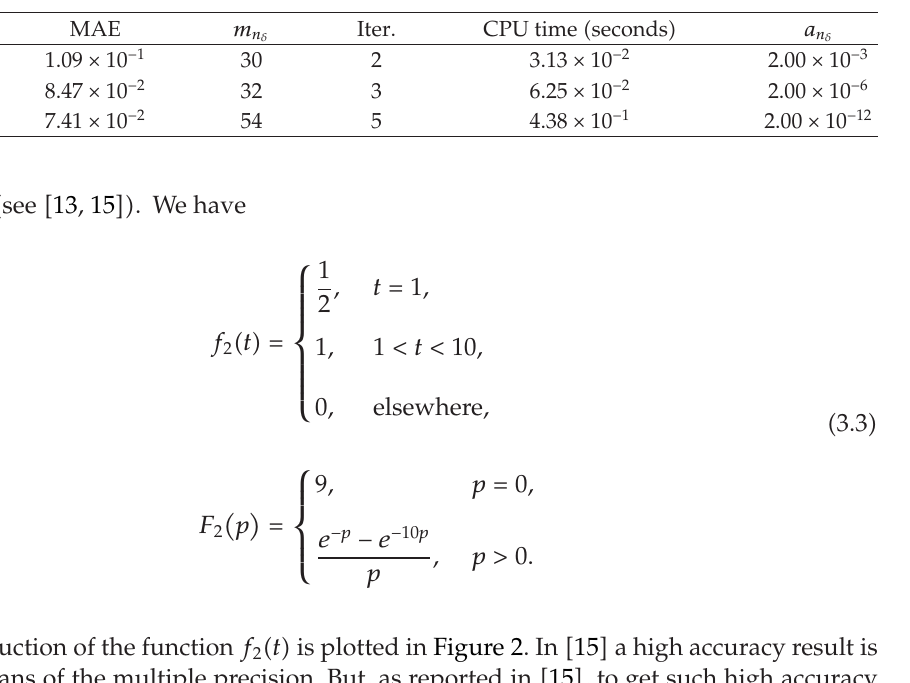
Figure 2: Example 3.2: the stability of the approximate solution. Table 2: Example